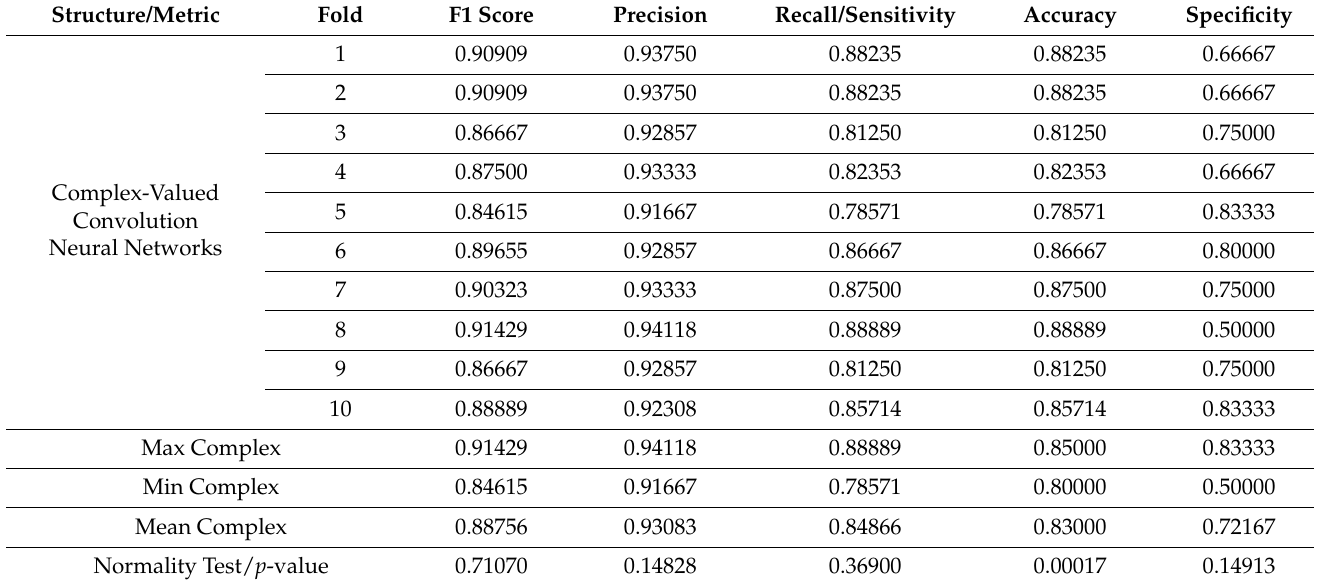
Table 9. Results obtained with the complex-valued convolution network studied for the PH2 dataset. Structure/Metric Fold F1 Score